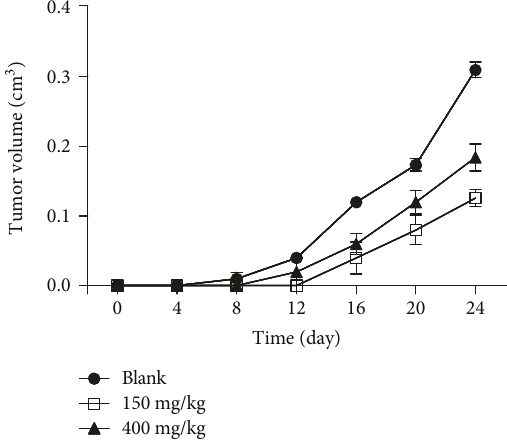
Figure 4: E ff ect of radix hedysari polysaccharide on the volume of tumor in nude mice with